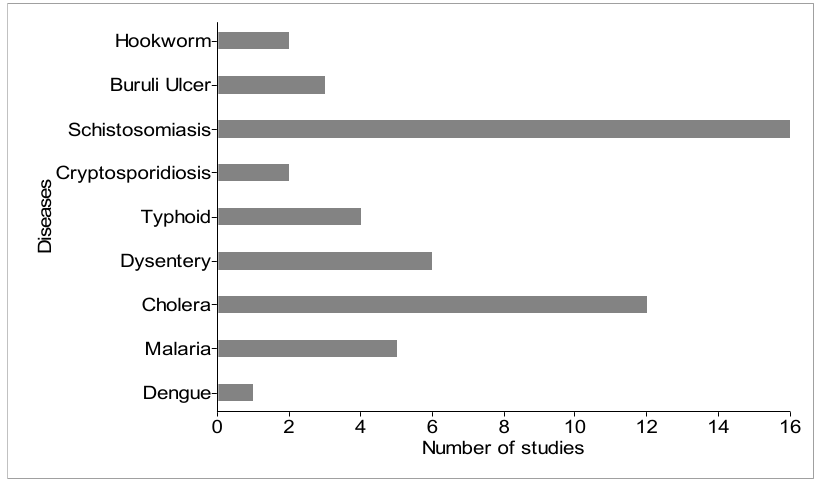
Figure 6. Infectious diseases related to land-use change and surface water quality.